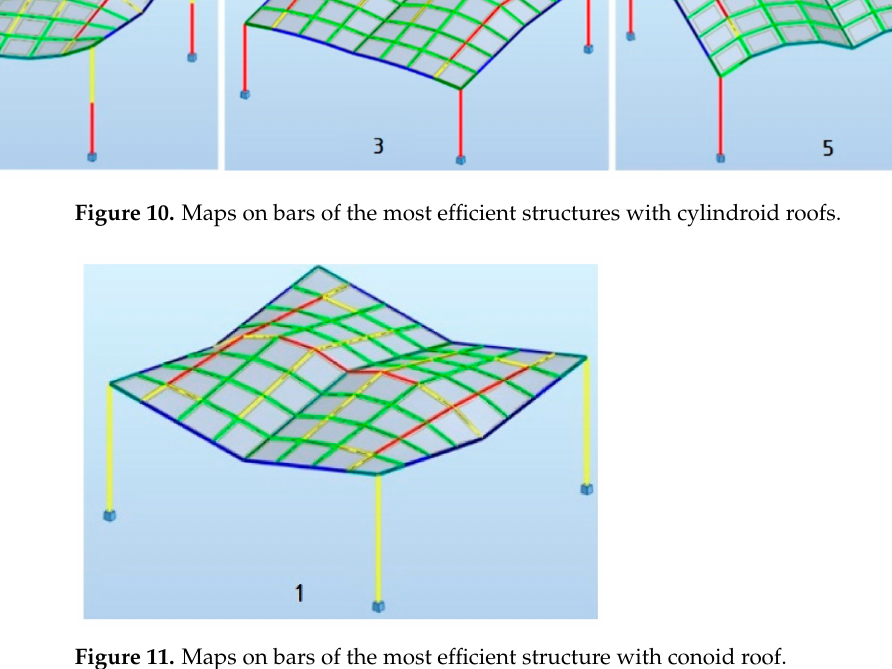
Figure 11. Maps on bars of the most efficient structure with conoid